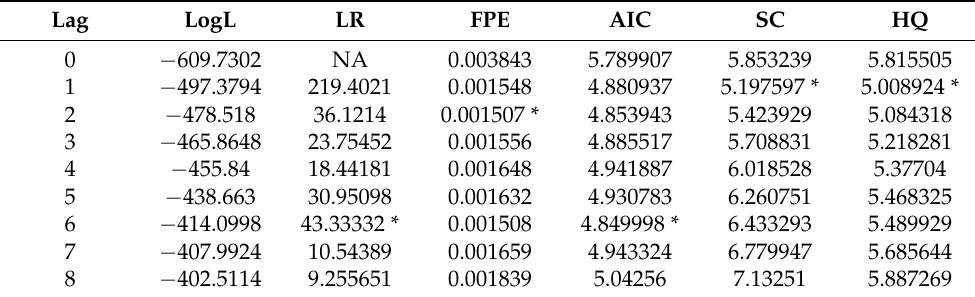
Table 6. Lag length criteria: GPR Israel, GPR Saudi Arabia, FSI, and FXFXD.